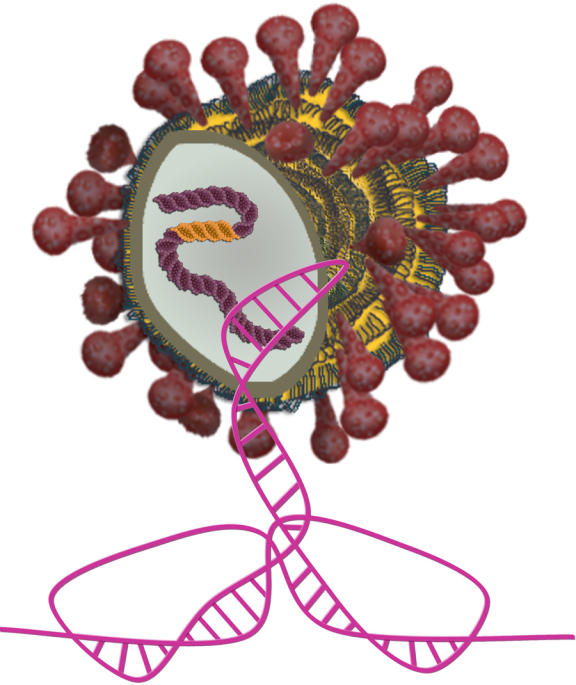
A three-stemmed pseudoknot in SARS messenger RNAs could provide a target for antiviral therapeutics (Image: Jonathan Dinman and the National Institute of Allergy and Infectious Diseases)